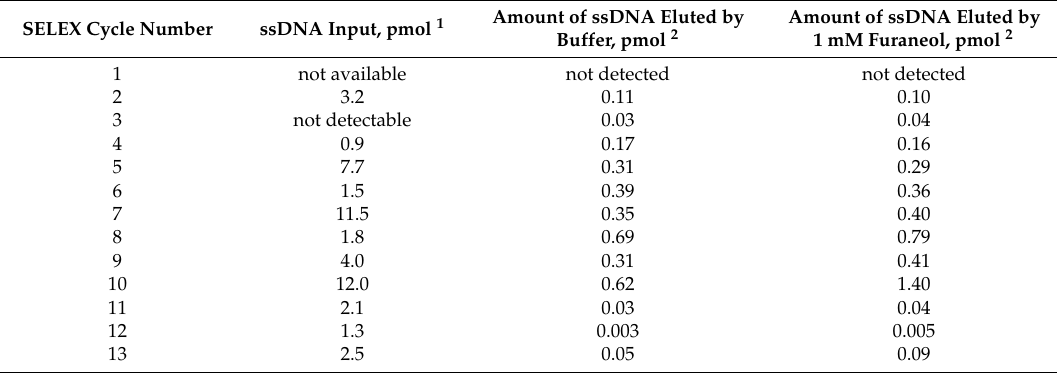
Table 1. The ssDNA load and elution during the aptamer